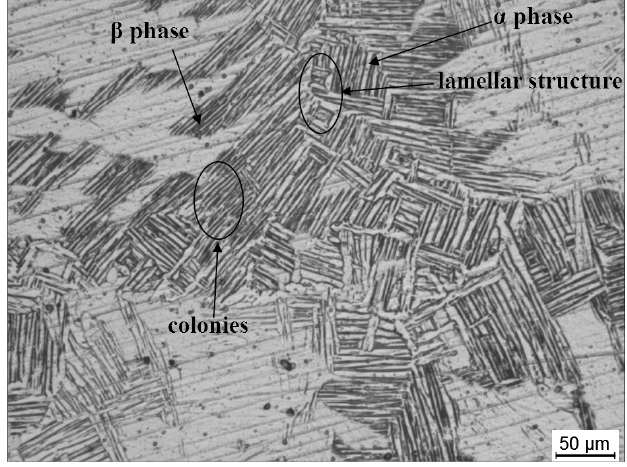
Figure 1. Microstructures of the titanium alloy TC7.